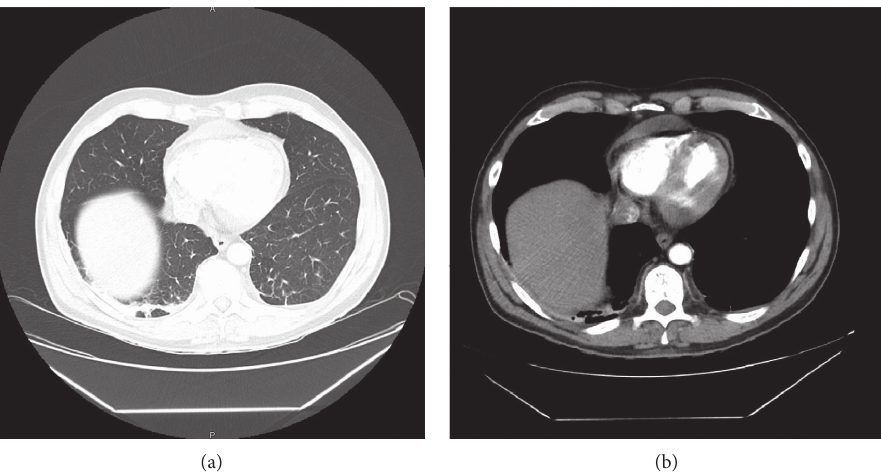
Figure 2: CTA chest with (a) and without (b) contrast enhancement demonstrating the moderate pericardial effusion. No pleural effusion or other abnormalities are